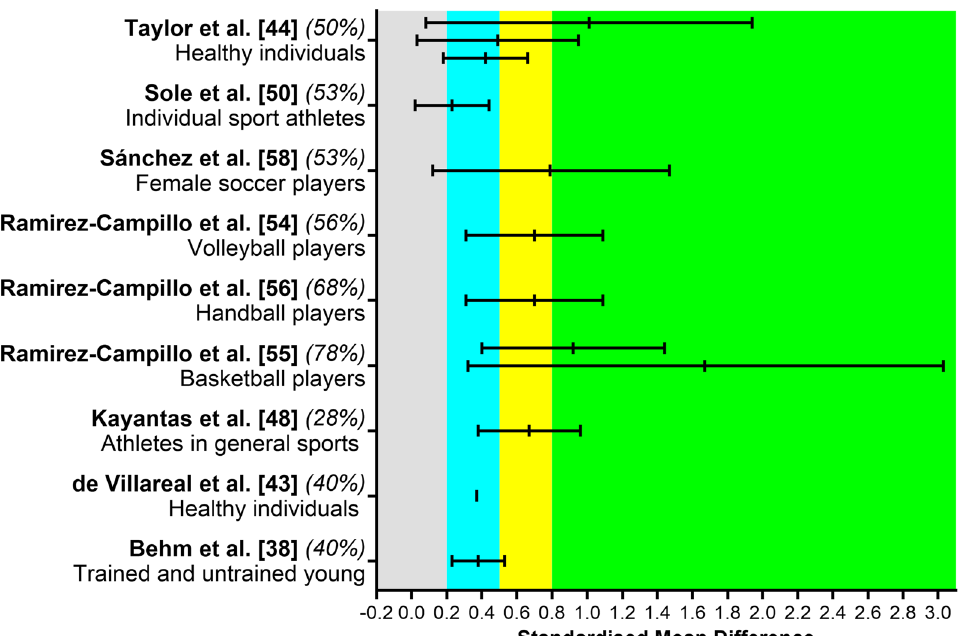
Fig. 2 Summary of standardized mean difference and 95% confidence intervals reported in meta‑analyses comparing the baseline to post‑plyometric training changes in sprint time. Author name and year are followed by the quality of the studies score ranked by AMSTAR 2. Positive values represent improved performance effects. Each colored area represents a different magnitude of effect: gray yellow moderate, and green large effects. De Villareal et al. [42] 95% confidence interval is not clearly described in their manuscript; therefore, = = we reported standardized mean difference only. Taylor et al. [43] reported results from 30‑, 20‑, and 10‑m sprints, presented in the respective order.